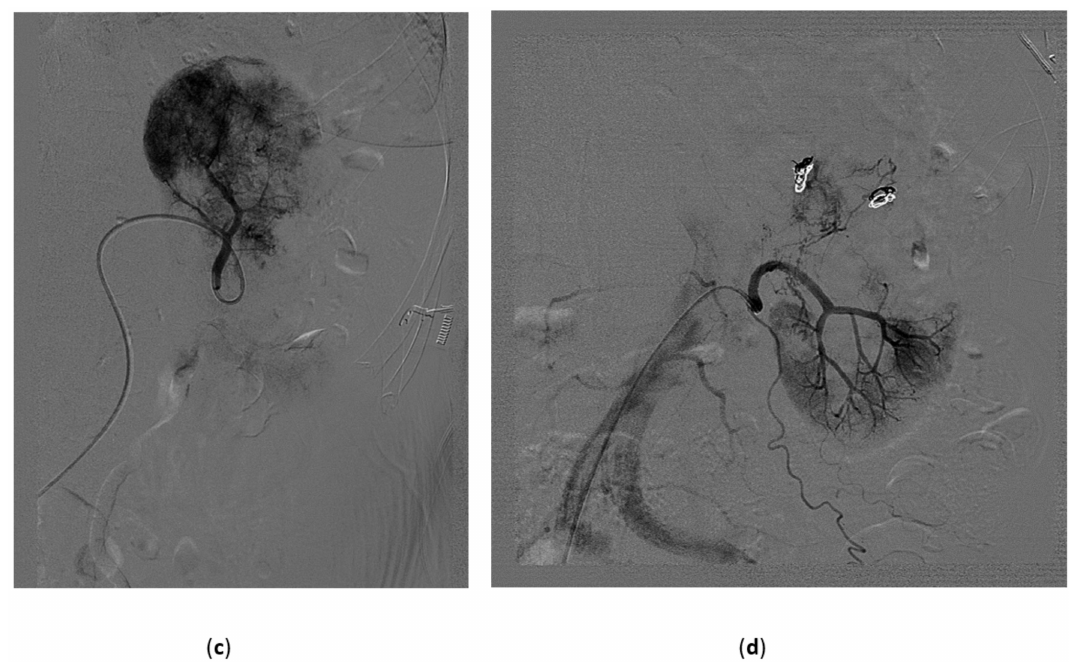
Figure 6. Malignant renal tumor. 91-year-old female with hematuria, anemia, and left flank pain. Palliative embolization of the left kidney was scheduled. ( a , b ) Contrast-enhanced CT (axial and sagittal plane) shows a huge not homogeneous mass of the superior half of the left kidney; ( c ) Selective angiography: rich vascularized renal lesion. ( d ) Angiogram (after embolization): the lesion is no longer visible; the inferior pole of the left kidney shows normal